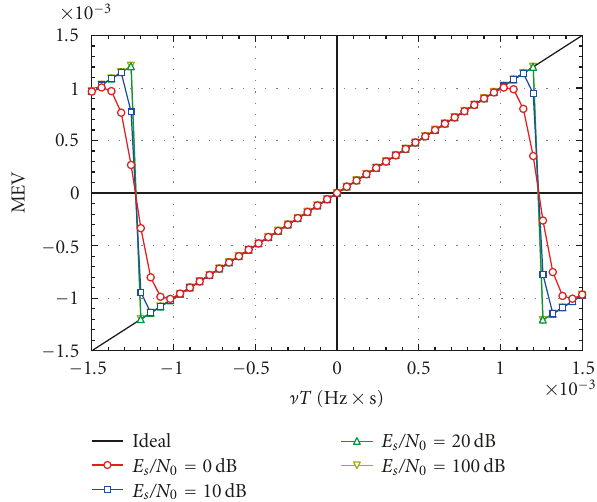
Figure 2: MEV of FEPE estimator for di ff erent values of E S /N 0 — simulation only. Preamble + postamble DA ML phase estimation, N = 44, M =